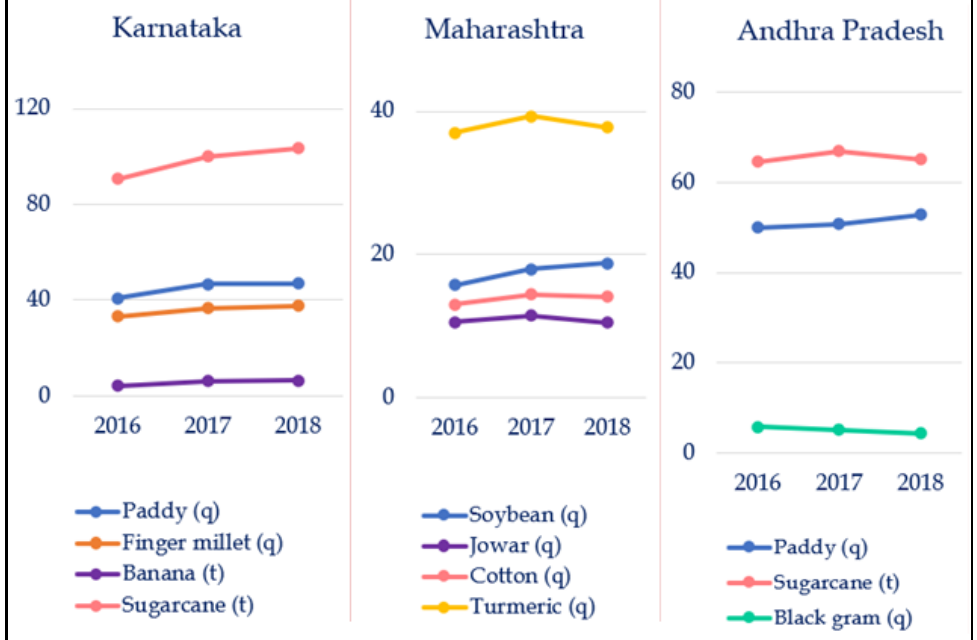
Figure 5. Trend in yield (t/ha or q/ha) of major crops under NF from 2016 to 2018 {t-tonne (1t=1000 kg), q-quintal (1 q = 100 kg)}.